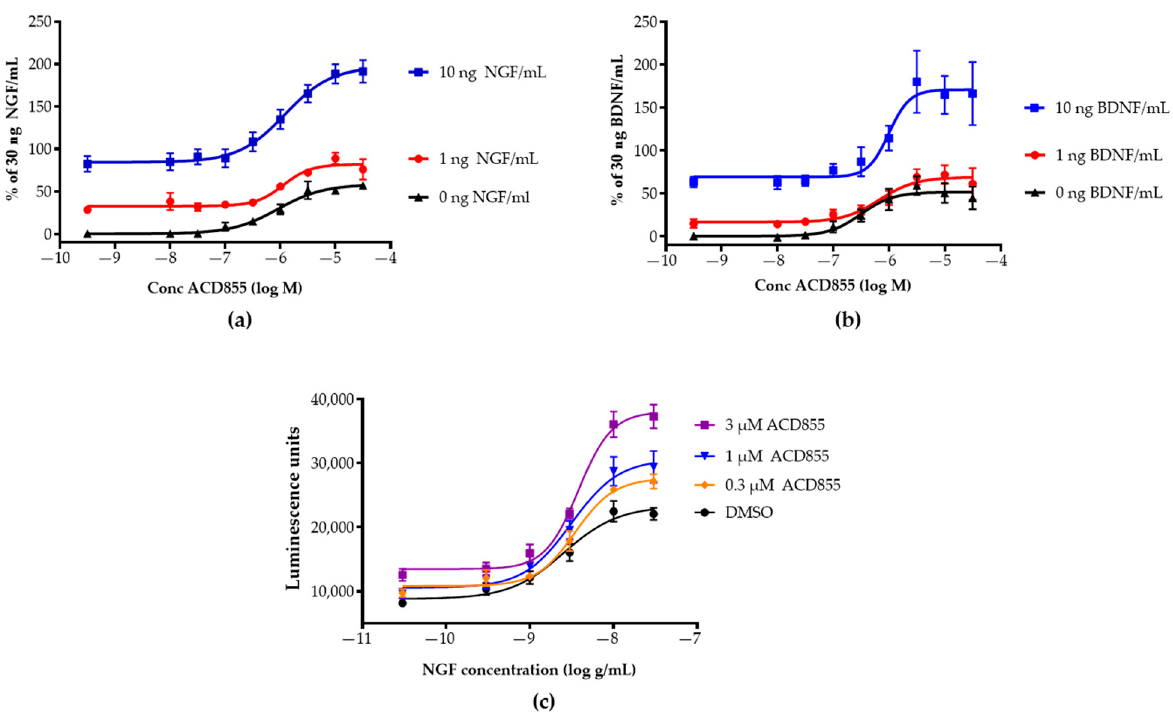
Figure 2. In vitro effects of ACD855 on NGF- or BDNF-signaling. U2OS cells expressing TrkA or TrkB were used to determine the effects of ACD855 at different concentrations of NGF or BDNF or to determine the effects of ACD855 on the dose–response curve of NGF. U2OS-TrkA ( a ) or U2OS-TrkB ( b ) cells (5000 cells per well) were incubated with an increasing amount of ACD855 and a fixed concentration of NGF ( a ) or BDNF ( b ), as indicated (0 ng/mL (black lines and triangles), 1 ng/mL (red lines and circles), or 10 ng/mL (blue lines and squares). 100% was defined as the activity obtained with 30 ng NGF/mL. ( c ) U2OS-TrkA cells were incubated with DMSO or with 0.3, 1, or 3 µ M of ACD855, as indicated in the absence or presence of increasing amounts of NGF to achieve complete dose–response curves of NGF. Luminescence units were the total amount of luminescence obtained at all wavelengths from each well. The amount of luminescence was a direct measurement of the amount of SHC-1 interacting with the phosphorylated tyrosine residue 490 of the TrkA and thus an indirect measurement of receptor